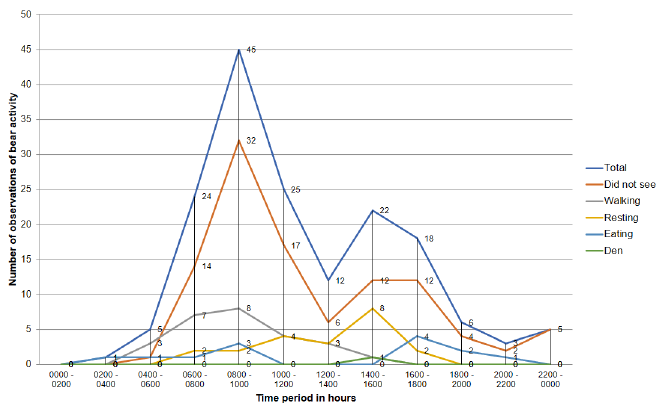
Fig 8. Activity of the sloth bear prior to the attack against a 24-hour